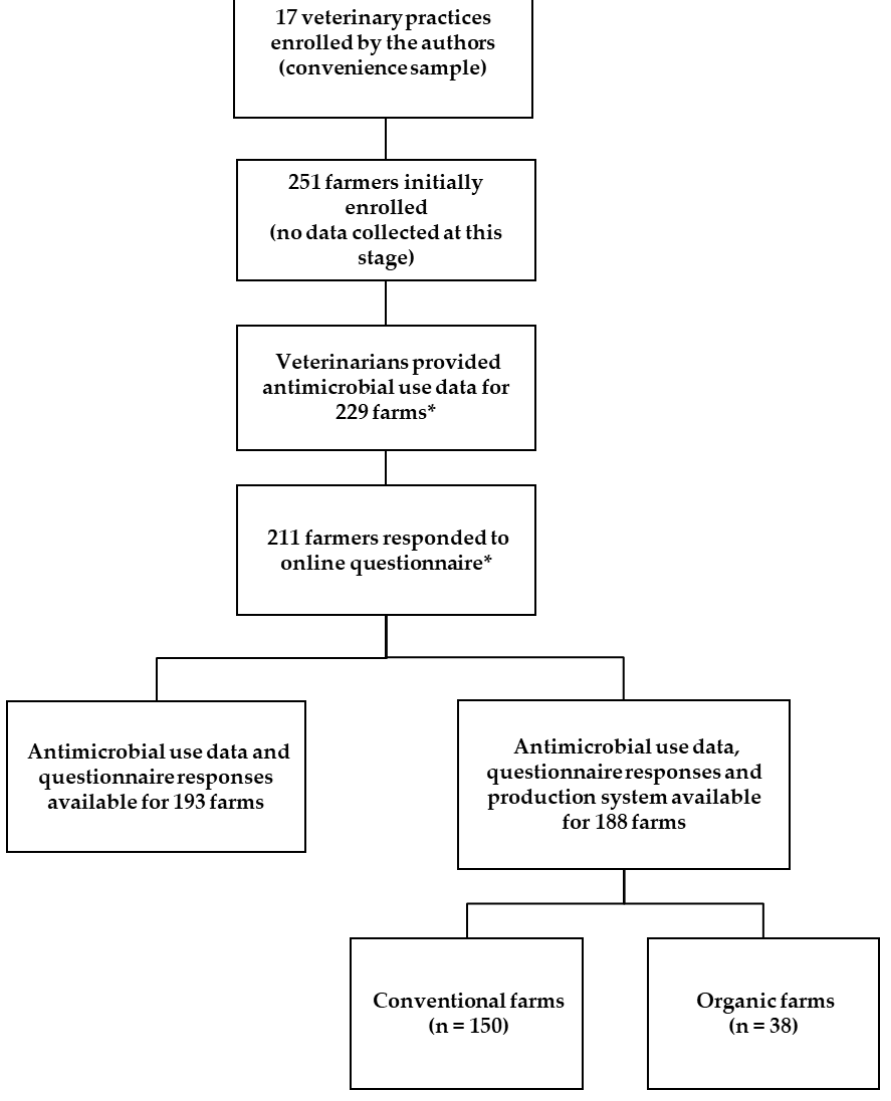
Figure 1. Flow chart of study participants. *These farms did not necessarily overlap; some farms provided questionnaire responses but no treatment data was available, and vice versa.